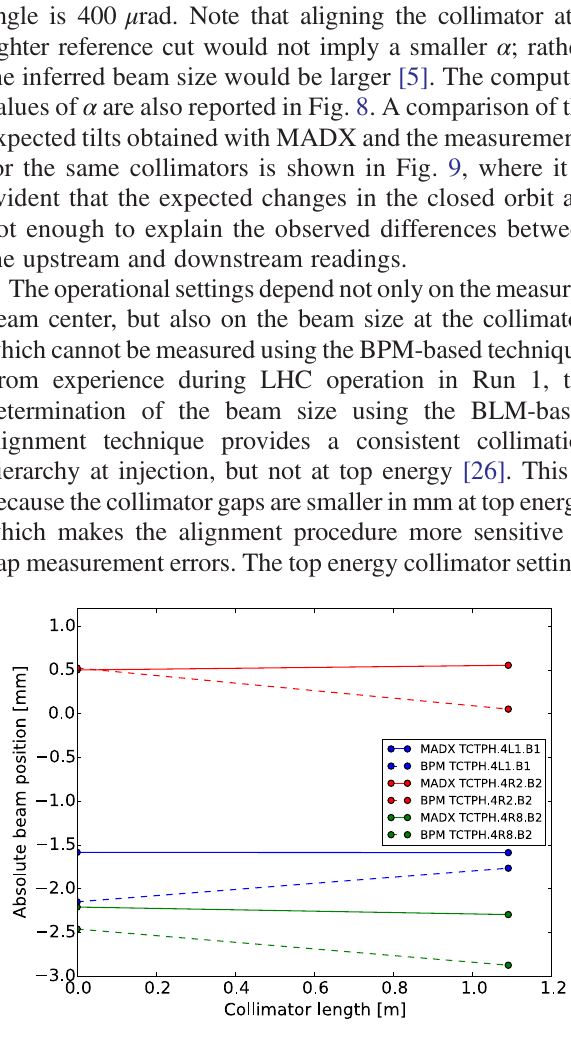
FIG. 9. Comparison of upstream and downstream beam posi- tions in three collimators expected from MADX and those found in the BPM-based